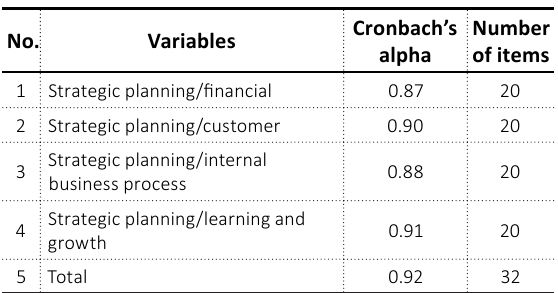
Table 1. Reliability testing